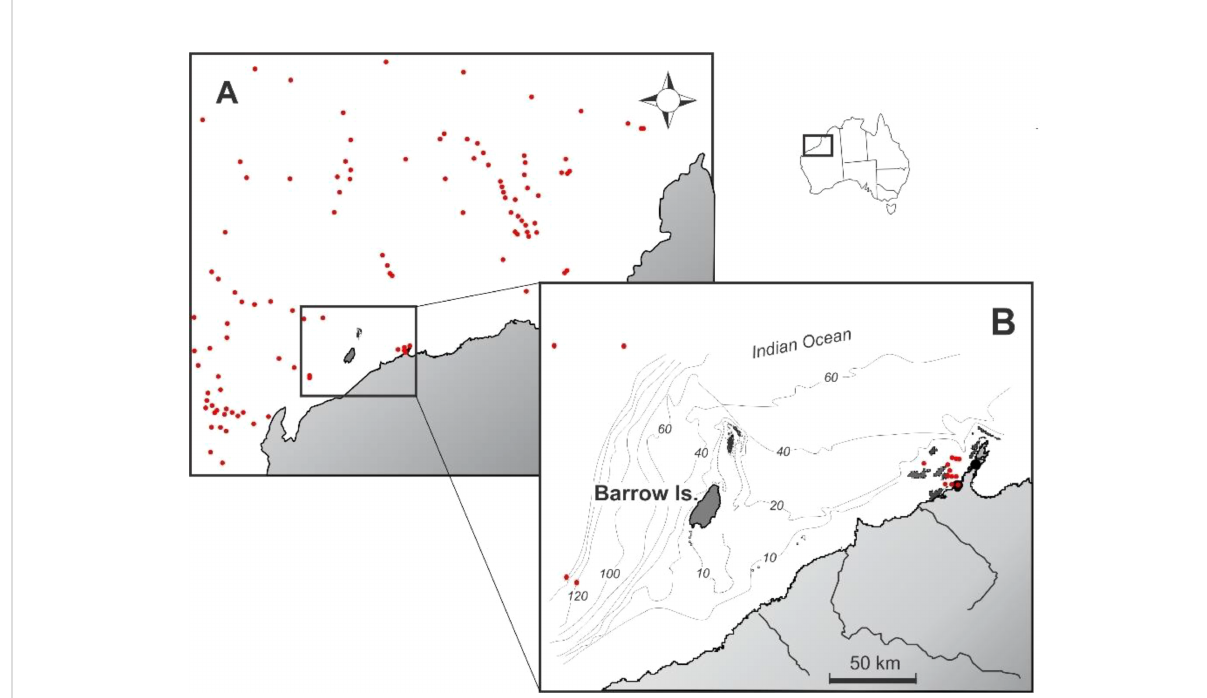
FIGURE 4 Available marine core data from Geoscience Australia for (A) the North West Shelf and (B) around Barrow Island, where archaeological records go back 50,000 years (sourced from